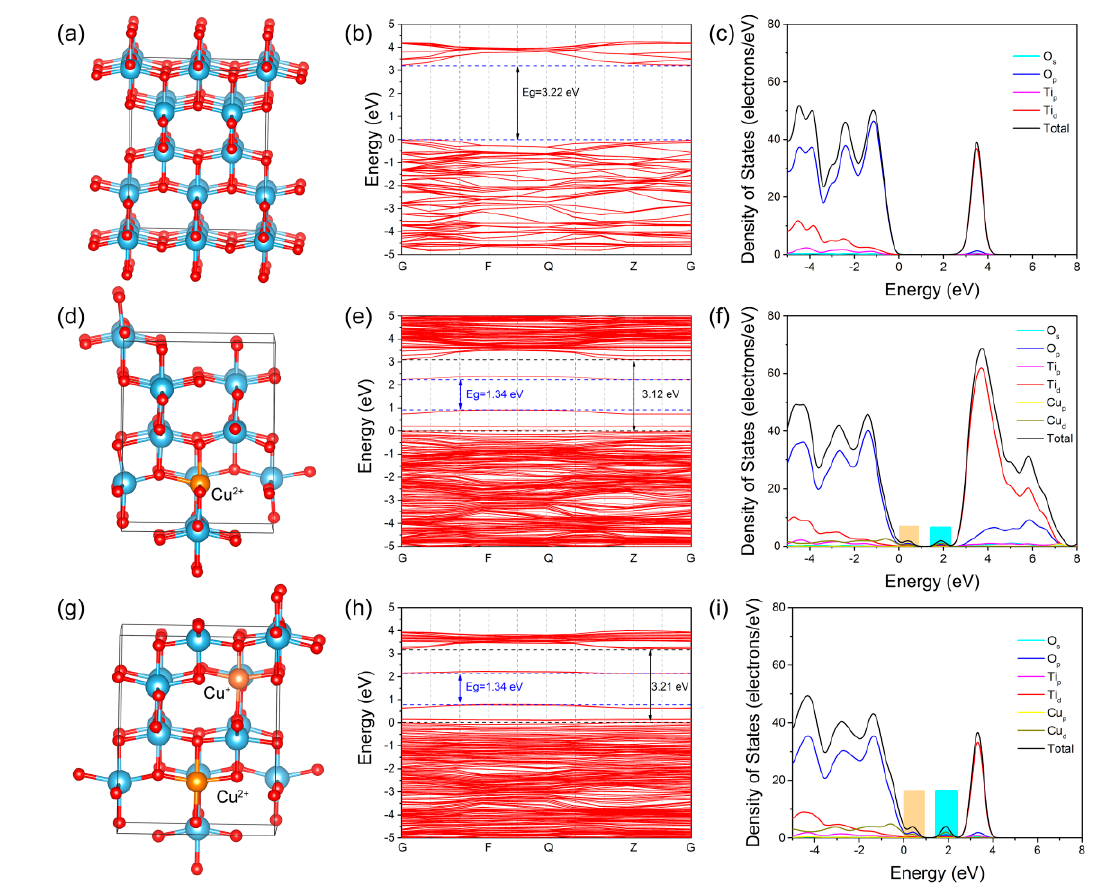
Figure 9. The lattice structure, calculated band structure and density of states (DOS) of: perfect anatase TiO 2 ( a – c ); Cu 2 + -doped TiO 2 ( d – f ); and TiO 2 with Cu 2 + and Cu + codoped ( g – i ).